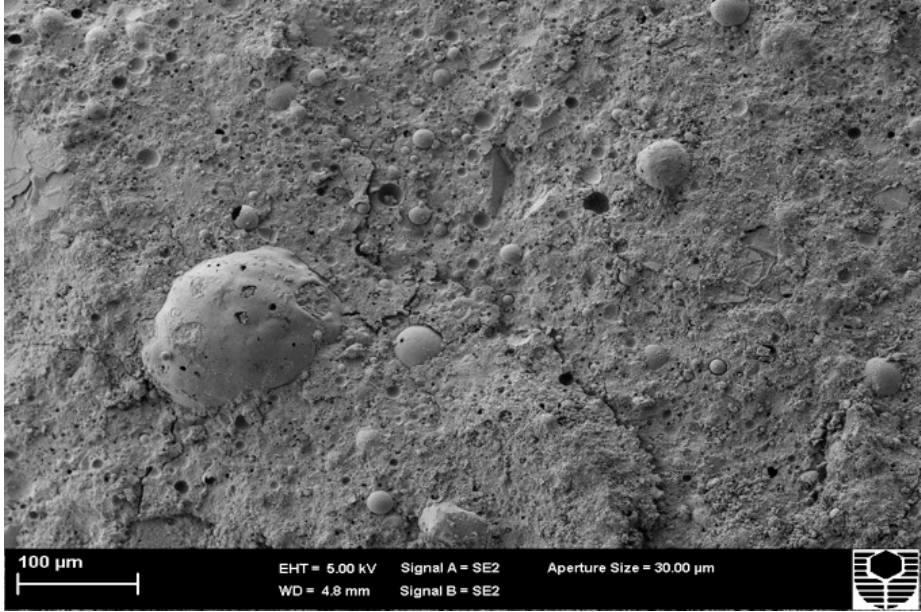
Figure 5. Microstructure of Mix 1 for FA and MK-based geopolymer.